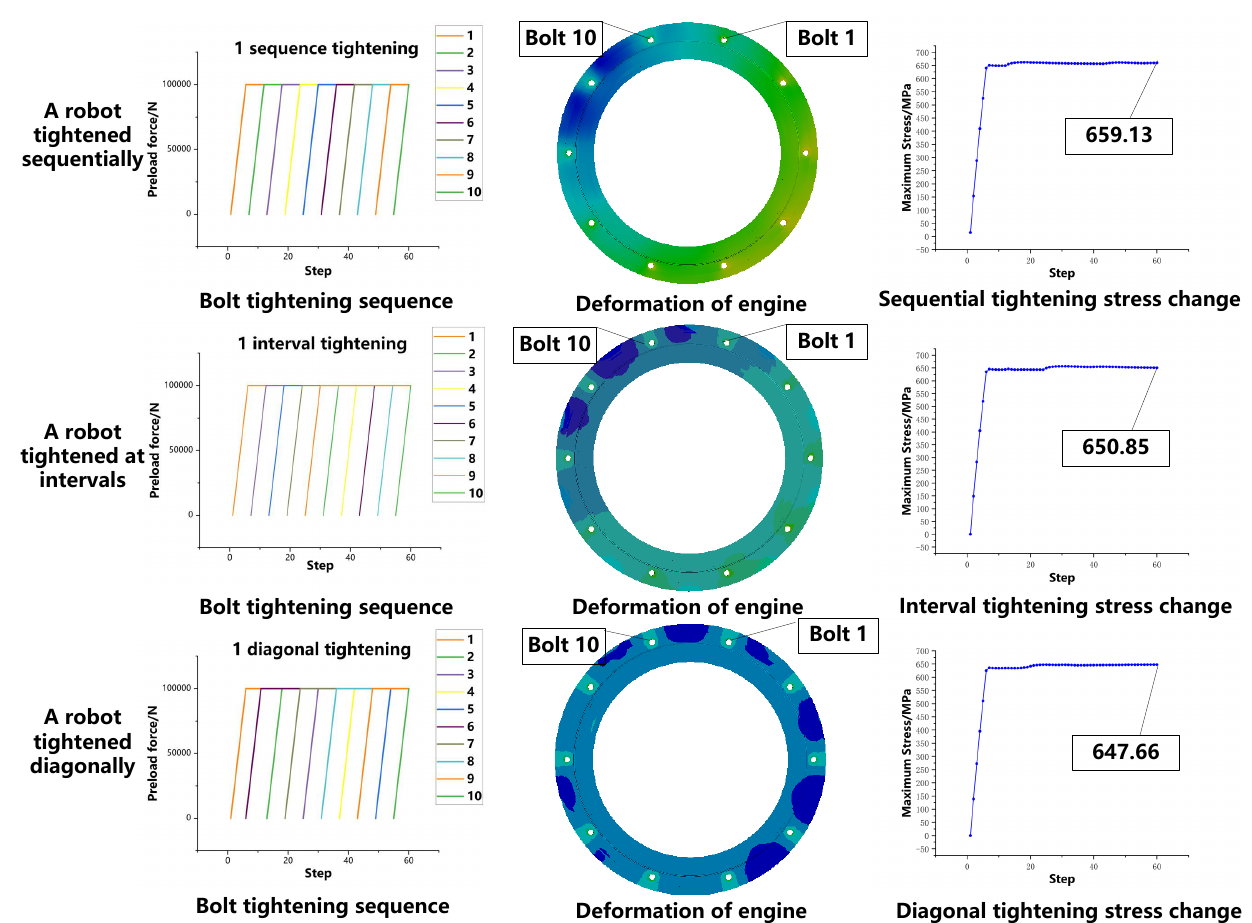
Figure 10. Deformation and stress of the engine compartment when a robot bolt is used to tighten.